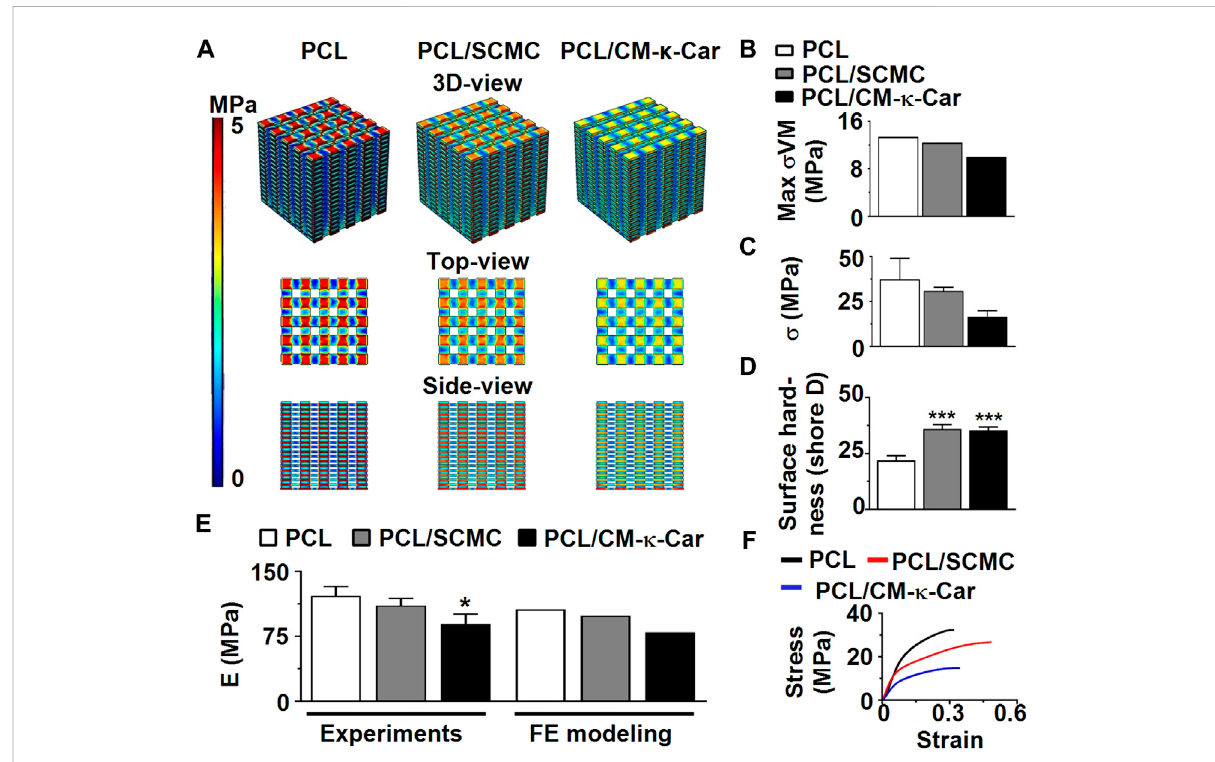
FIGURE 4 Effect of 3D-printed PCL scaffold surface-functionalization by SCMC or CM- κ -Car on mechanical properties. (A) 3D-view, top-view, and side- view of von Mises stress distribution on the scaffolds as a result of uniform 2% compression strain deformation determined by FE modeling. (B) Maximum von Mises stress. (C) Compressive strength. (D) Surface hardness. (E) Elastic modulus determined experimentally and by FE modeling. (F) Stress-strain curve. Values are mean ± SD ( n = 3). *Signi fi cantly different from unfunctionalized 3D-printed PCL scaffold, p < 0.05, **** p < 0.0001.PCL,poly- ε -caprolactone;SCMC,sulfatedcarboxymethylcellulose;CM- l -Car,carboxymethyl κ -carrageenan;FE, fi